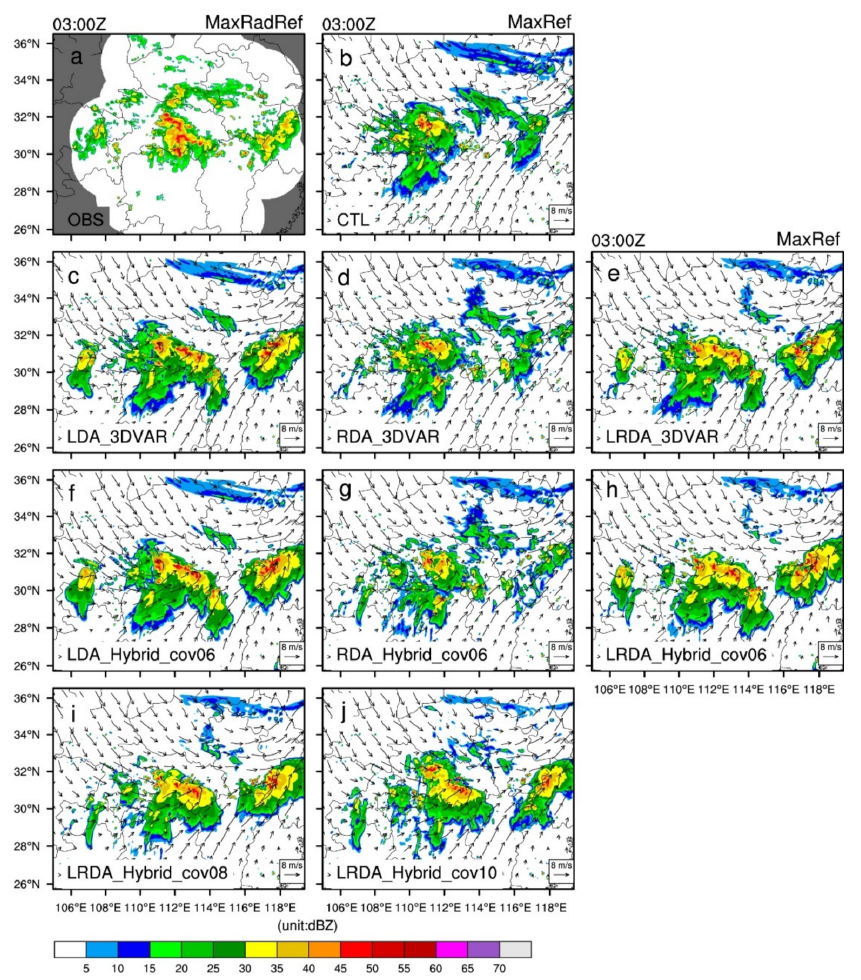
Figure 7. The observed maximum radar reflectivity and forecasted maximum reflectivity and horizontal wind vectors from single-analysis experiments at 0300 UTC on 30 June 2018 (i.e., 3 h forecast). ( a ) Observed maximum radar reflectivity interpolated onto the 3 km simulation domain (OBS), ( b ) control run (CTL), lightning ( c , f ), radar ( d , g ), and combined lightning and radar data assimilation ( e , h ) by 3DVAR ( c – e ) and hybrid 3DEnVAR ( f – h ) showed that β 1 = 0.4, β 2 = 0.6. The combined lightning and radar data assimilation by hybrid 3DEnVAR ( i , j ) showed that β 1 = 0.2, β 2 = 0.8 and β 1 = 0.0, β 2 = 1.0,